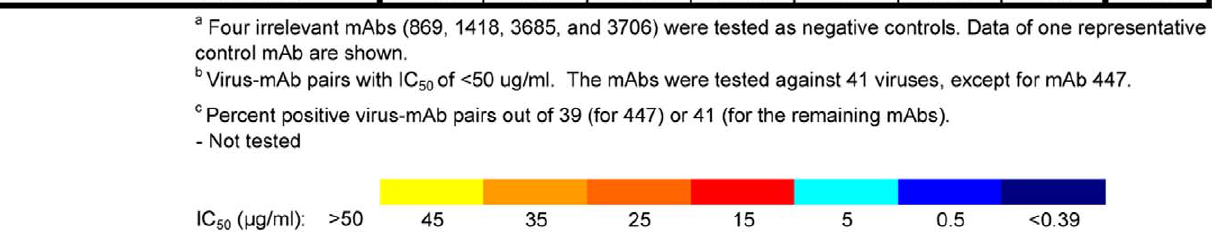
Figure 6. The IC 50 values of anti-V3 mAbs against 41 HIV-1 pseudoviruses tested using the U87 target cell line. The IC 50 values were estimated from the titration curves of all mAb/psV combinations and are shown with the color-coded scale. When 50% neutralization was not achieved at the highest mAb concentration tested (50 m g/ml), the IC 50 values are shown as . 50. Four different irrelevant mAbs (860, 1418, 3685, and 3706) were used as negative controls in this experiment with comparable results, but only the mAb 860 data are shown.